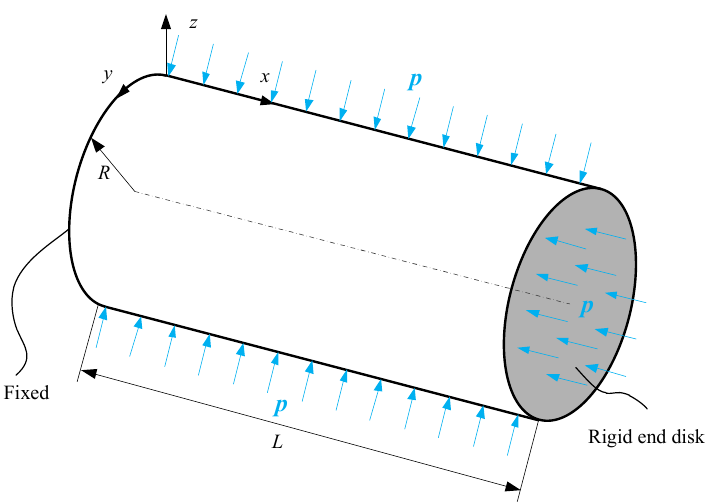
Figure 1. Composite cylindrical shell with cantilever-like boundary conditions under hydrostatic pressure.